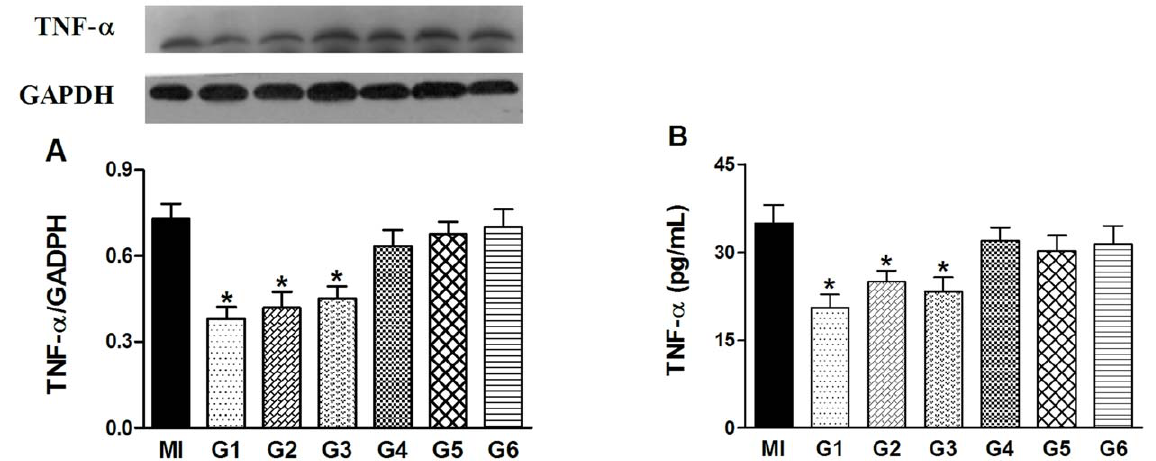
Figure 6. Effects of vagus nerve stimulation on myocardial and plasma level of tumor necrosis factor- a (TNF- a ) in MI and G1–G6 group. (A) Representative blots and densitometric analyses of TNF- a protein expression, normalized against GADPH. (B) Arterial blood levels of TNF- a , as determined by ELISA. Data are the mean 6 SEM (n=8). * P , 0.05 compared with MI group.